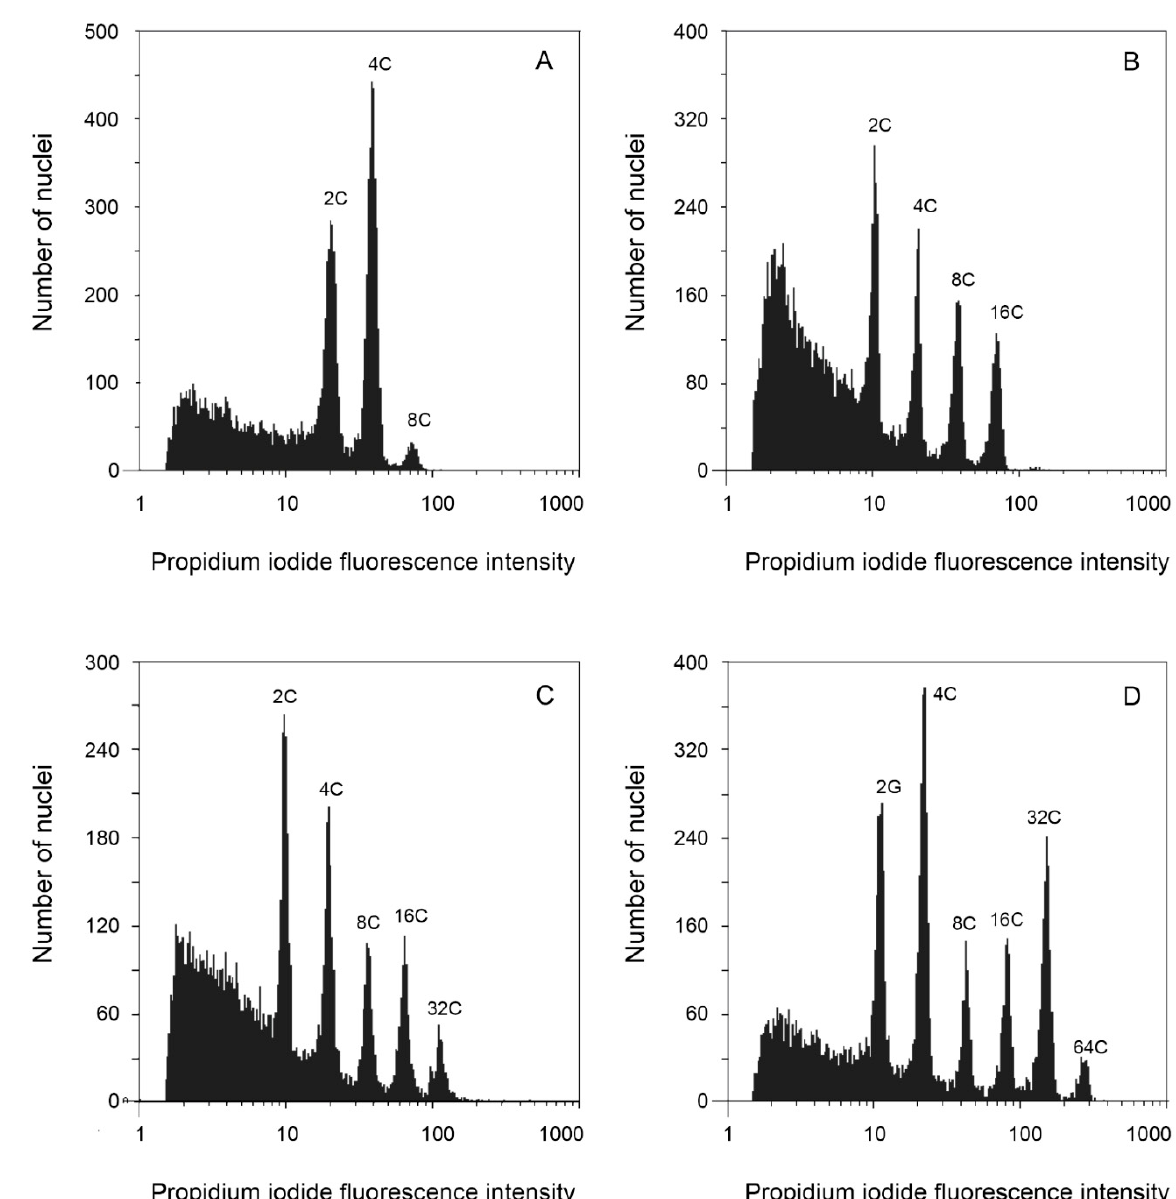
Figure 6. Endopolyploidy pattern in leaf parenchyma of four Echeveria species. X -axis is displayed in logarithmic scale. ( A ) E. roseiflora endopolyploidy pattern showing one endocycle ( B ) E. altamirae endopolyploidy pattern showing two en- docycles. ( C ) E. gibbiflora endopolyploidy pattern showing three endocycles. ( D ) E. caamanoi endopolyploidy pattern showing four endocycles .